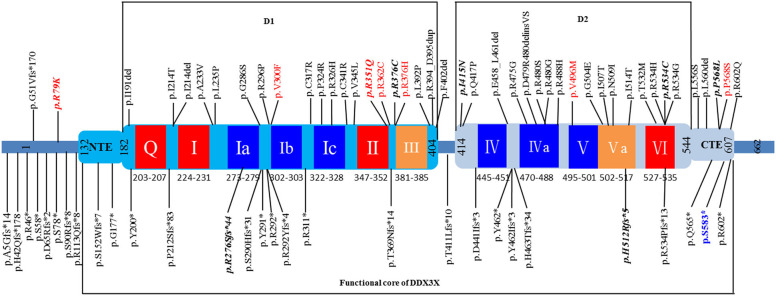
Schematic view of the DDX3X protein structure based on Song et al. (26) showing D1D2, NTE, and CTE fragments. The 12 highly conserved sequence motifs are color coded: red, ATP binding; blue, RNA binding; orange, coordination between ATP and RNA binding. Unique variants (total: 73) are listed in the schematic view, showing the location of the variant identified in our patient (p.S583* in blue). The variants found in affected males are shown in red, and recurrent variants are indicated with bold italics. The 8 splice site variants identified in published cohorts are not shown in this figure.